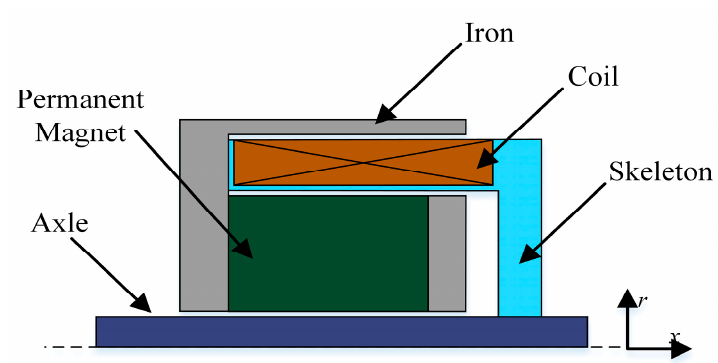
Figure 4. Structure of the linear electric machine (LEM).